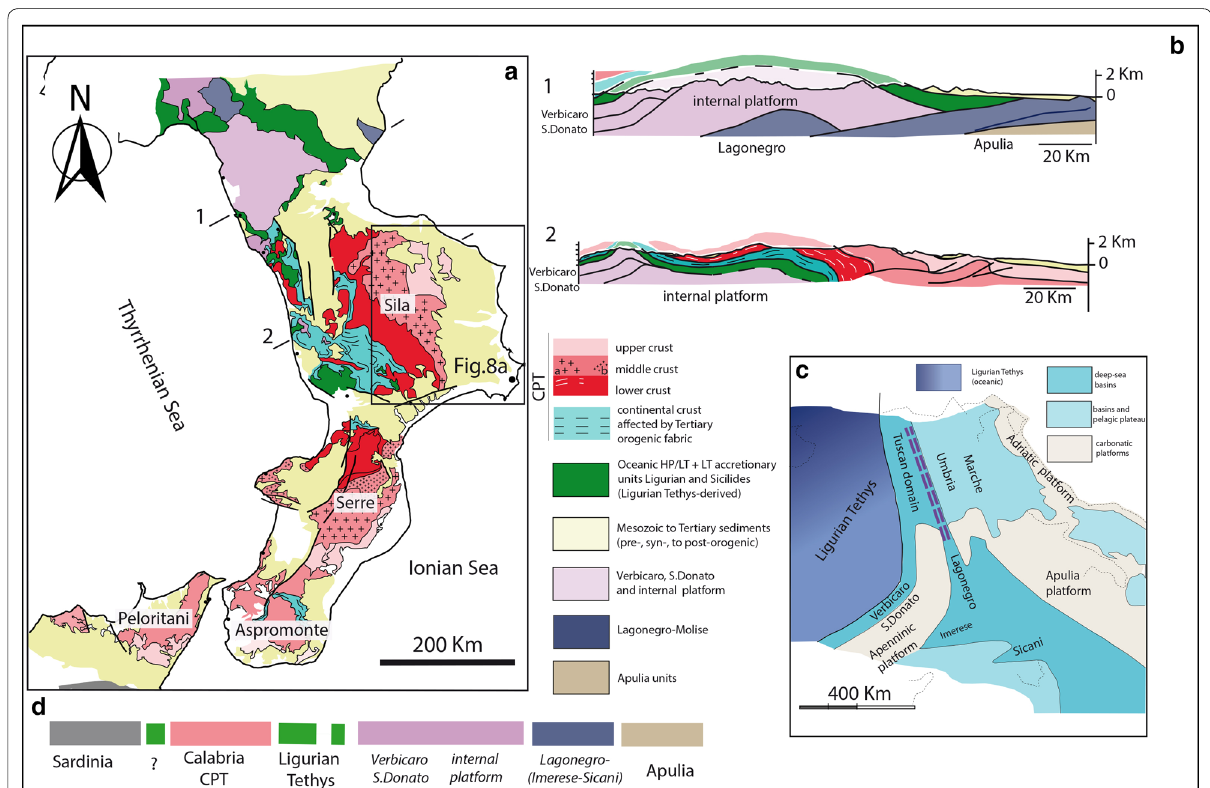
Fig. 6 a Schematic geological map of Southern Apennines-Calabria-Peloritani showing the main groups of tectonic units (based onAmodio-Morelli et al. 1976; Bonardi et al. 2001; Vitale and Ciarcia 2013); b regional cross-section of the northern Calabria (based on Elter, Scandone 1980); d restoration of the Central Mediterranean region showing the distribution of the Central and Southern Apennine platforms and basins (after Patacca and Scandone 2007). The palinspastic reconstruction shows the position of Lagonegro-Imerese-Sicani and the northward prolongation between Tuscan and Umbria-Marche domains. This Mesozoic setting includes inheritance of former Permian precursors related to a major regional fault system, whose location is indicated as violet dashed line see text; e simplified paleotectonic frame showing the main domains involved in Southern Apennines-Calabria-Peloritani orogenic building and their relative pre-Mesozoic